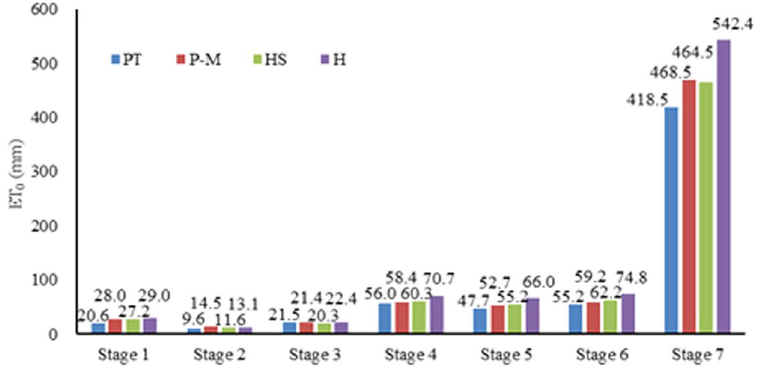
Figure 3. Comparison of ET 0 estimated by different methods in the 2015–2016 different stages at the Experimental Station located in Xinxiang, Henan Province, China (mm).